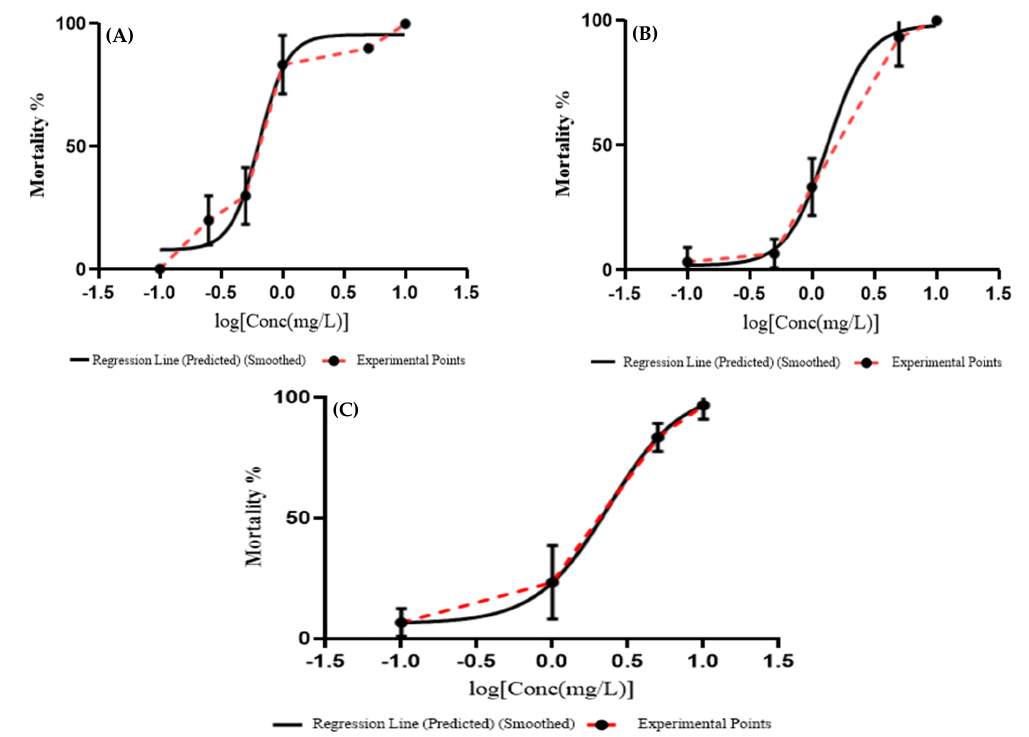
Figure 4. Graph of the mortality (%) against the concentration of ZnO NPs (mg/L) in ( A ) ultra-pure water, ( B ) deionized water, and ( C ) dechlorinated tap water. The lethal concentration (50%) value for ZnO NPs determined by probit analysis at different concentrations (0, 0.100, 0.250, 0.500, 1, 5, and 10 mg/L) for 96 h.